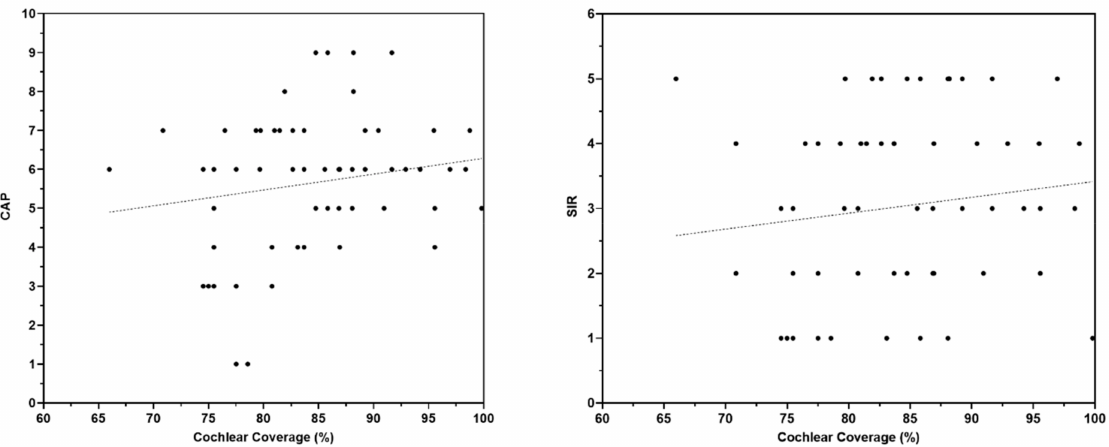
Figure 3. Regression analysis comparing the cochlear coverage with the Categories of Auditory Performance (CAP; left panel ) and the Speech Intelligibility Rating (SIR; right panel ) scales. Further analyses of the individual electrodes revealed that the FLEX 28 electrode array, which had a cochlear coverage of 73.92 ± 16.06%, was associated with significantly better ( p = 0.031) SDS compared with the FORM 24 electrode array, which had a cochlear coverage of 67.27 ± 15.12% (Figure 4). Figure 5 shows the 3D segmented angular insertion depth of the FORM 24 electrode (460 ◦ ), and the FLEX 28 electrode array inserted up to 530 ◦ for illustrative purposes. These images were generated from postoperative CT scans of two patients enrolled in this study.